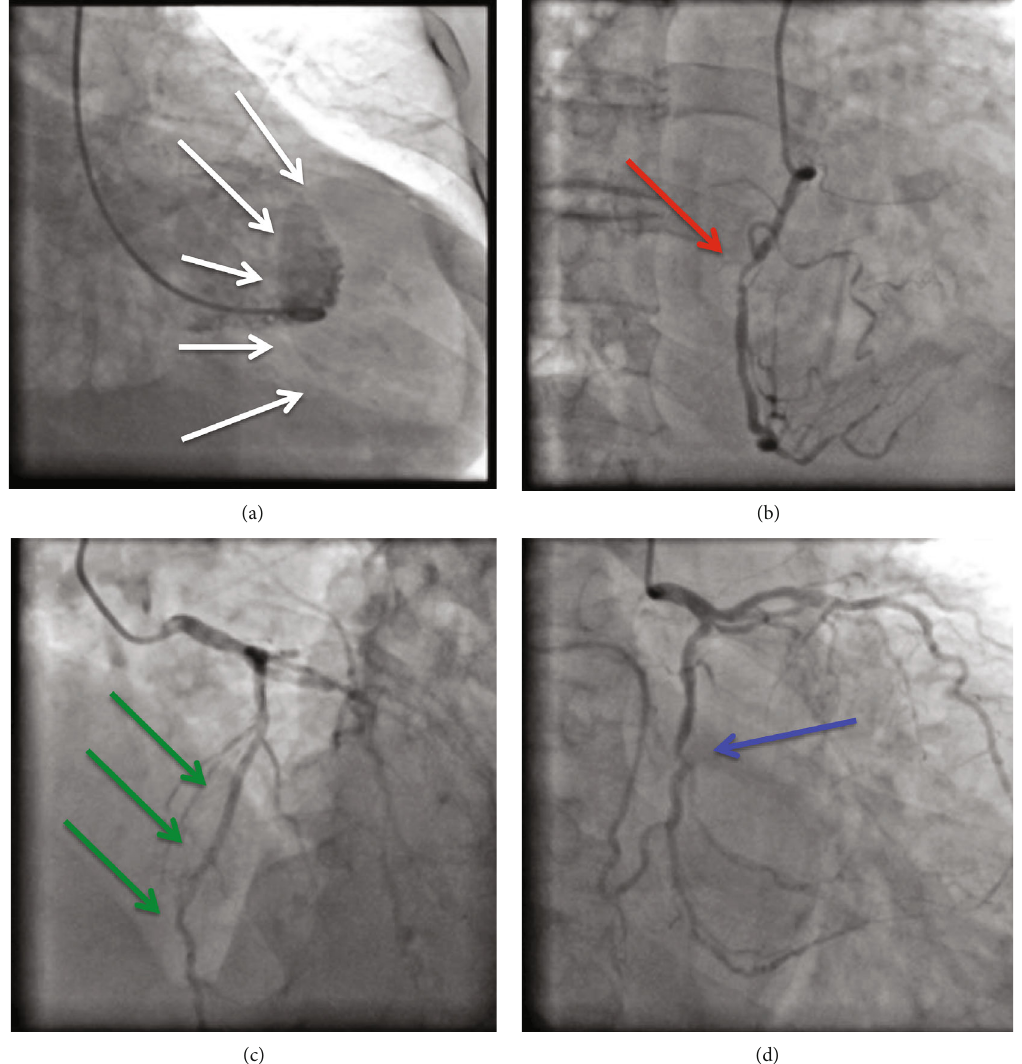
Figure 2: Left ventriculogram and coronary angiogram. (a) Left ventriculogram in right oblique view showing important contrast extravasation from the left ventricle to the pericardium forming a giant pseudoaneurysm (white arrows). (b) Coronary angiogram in right oblique view showing severe stenosis (80% lumen stenosis) in middle segment of the right coronary artery (red arrow). (c) Coronary angiogram in left cranial view showing normal left anterior descending artery (green arrows). (d) Coronary angiogram in right caudal view showing intermediate stenosis (40% lumen stenosis) in the left circum fl ex artery (blue